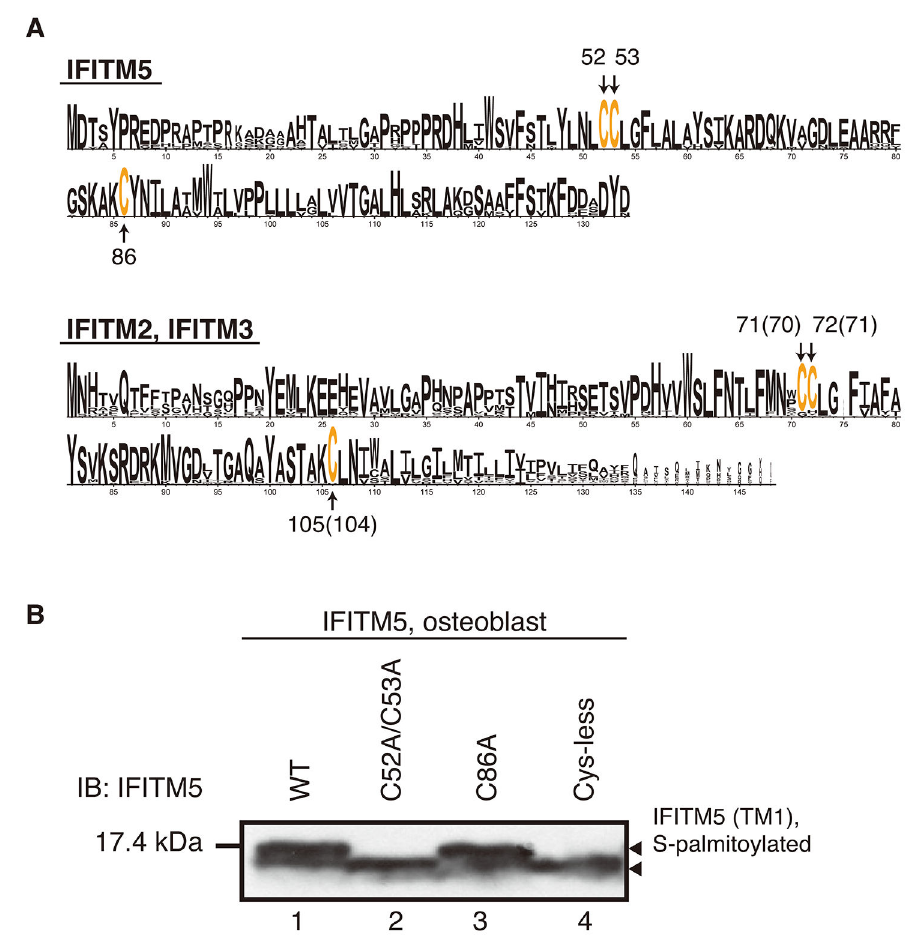
Figure 3. S-palmitoylation sites on IFITM5. A) Amino acid occurrence in putative mammalian homologs of IFITM5 (upper panel), and IFITM2 and IFITM3 (lower panel). The conserved cysteines are highlighted in orange and numbered. In the lower panel, the numbers given in parenthesis correspond to the residual number for IFITM2. For the calculation of probability, a total of 23 IFITM2, 23 IFITM3, and 17 IFITM5 sequences derived from mammalian species in the Kyoto Encyclopedia of Genes and Genomes (KEGG) database were used. Sequence alignment was carried out using CLUSTALW. Sequence logos were generated using WEBLOGO 3. B) Western blot for the wild-type and cysteine-substituted mutants of IFITM5 expressed in the osteoblast cells. For detection, the anti-IFITM5 antibody was used as a primary antibody. The upper arrow indicates that C52 and/or C53 in the TM1 domain is S- palmitoylated (lanes 1 and 3). The C52A/C53A (lane 2) and Cys-less (lane 4) mutants are partially and completely depalmitoylated. The experiment was carried out 2